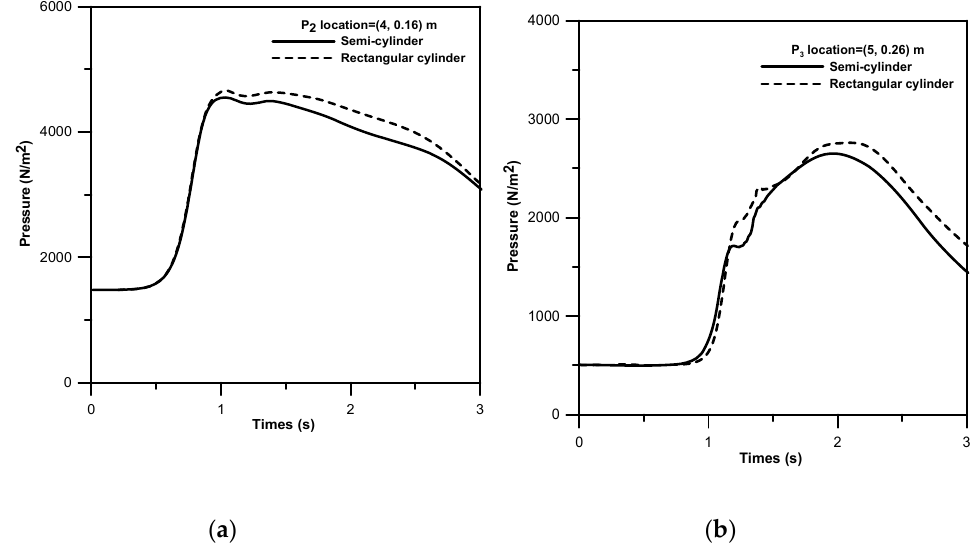
Figure 11. Comparisons between results (velocity and pressure) from the present model and Flow 3D simulations for the case of semicircular cylinder at point P1: ( a ) velocity and ( b ) pressure.